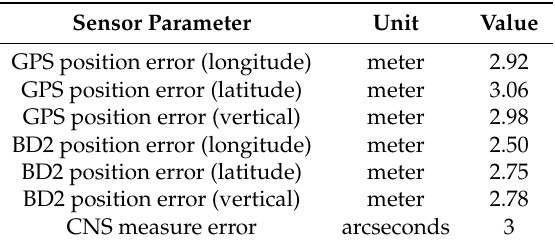
Table 2. Error of measurement.